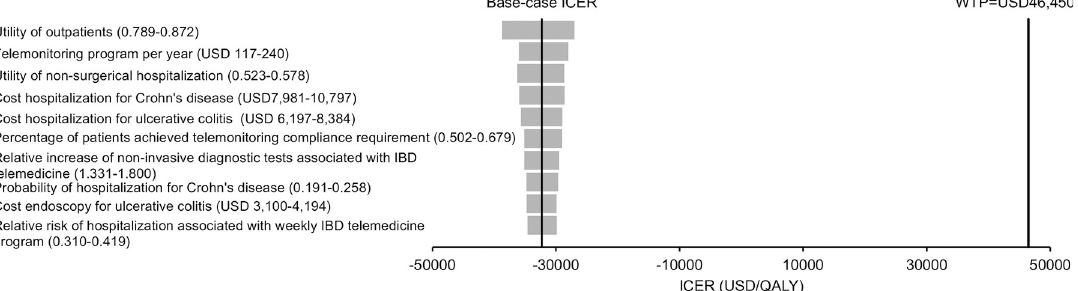
Fig 4. Tornado diagram of top ten influential factors identified on the ICER of SC-TM versus SC. QALY, quality-adjusted life-year; ICER, incremental cost-effectiveness ratio; SC, standard care with pandemic-related avoidance; TM, telemonitoring; WTP, willingness-